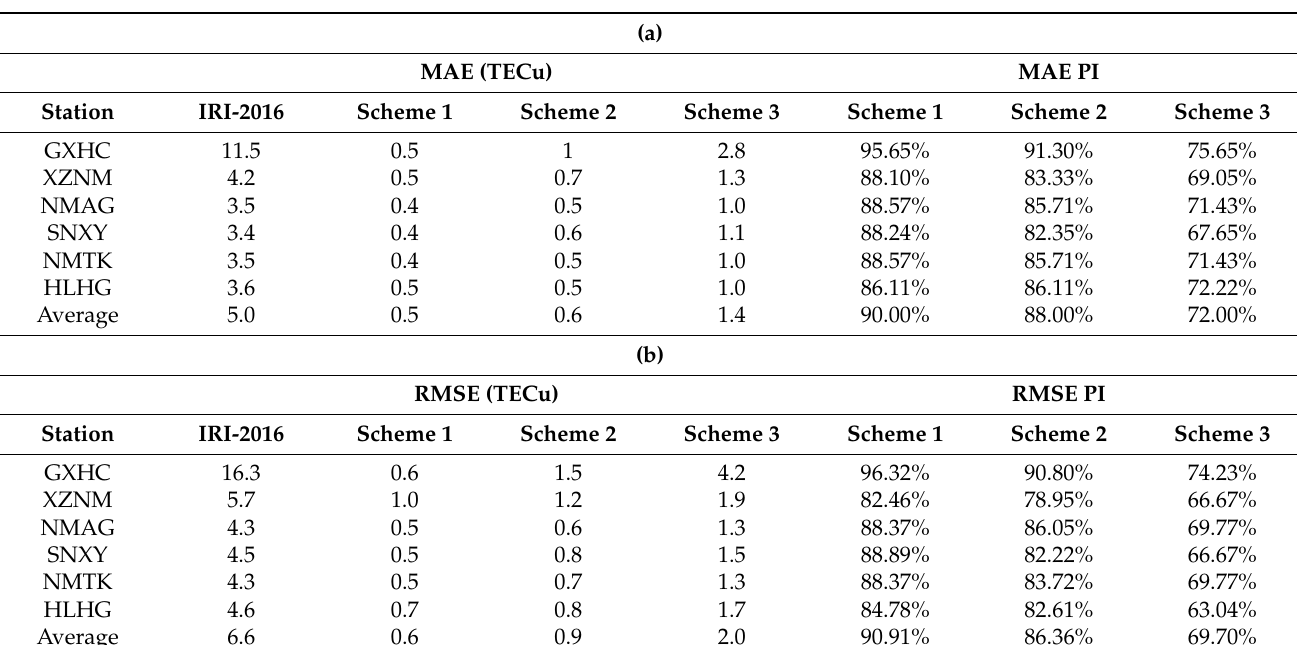
Table 1a through Table 2b record the accuracy indices, including the MAEs, RMSEs, and PIs, between the IRI-TEC calculated using the IRI-2016 model driven by the original IG 12 values and GNSS-TEC and between the modified IRI-TEC results calculated using the IRI-2016 model driven by the three different IG-up temporal interpolation schemes and GNSS-TEC in 2015 and 2019. The sampling interval used is 1 min. Table 1. ( a ). MAEs and MAE PIs for the TEC in 2015. ( b ). RMSEs and RMSE PIs for the TEC in 2015.